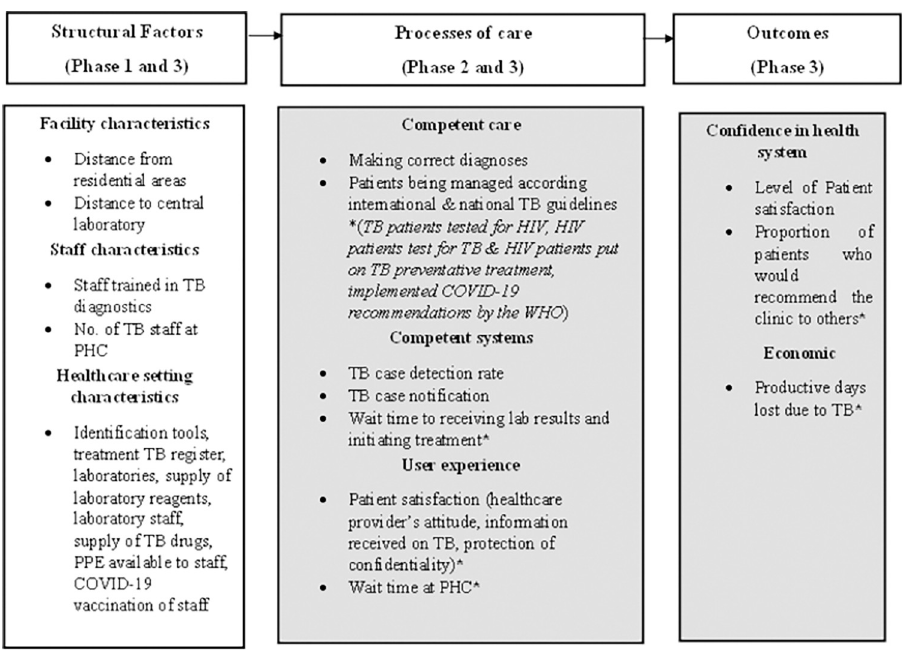
Fig 1. Conceptual framework for measuring quality of TB care for the study: Towards development of a novel approach for enhancement of TB diagnostic services during the pandemic: A case of primary health care clinics in eThekwini district